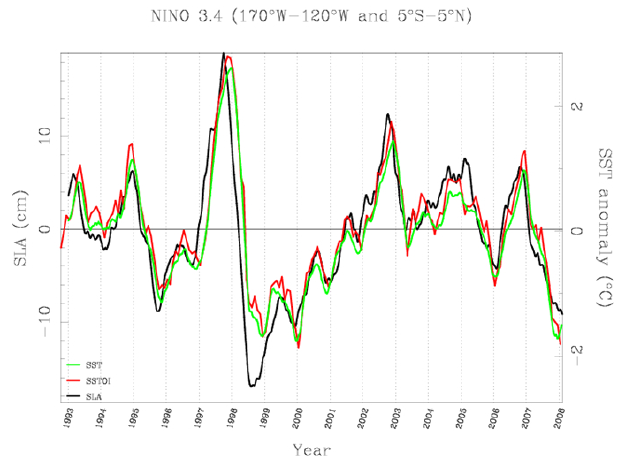
Fig. 2. Time evolution of SLA in black referenced to the 1993–2006 base period. In green the SST anomaly from Reynolds fields also referenced to the 1993–2006 base period, and in red the SST anomaly from NOAA ERSST.v2 fields referenced to the 1971–2000 base period. The latter is plotted from the ascii file obtained at